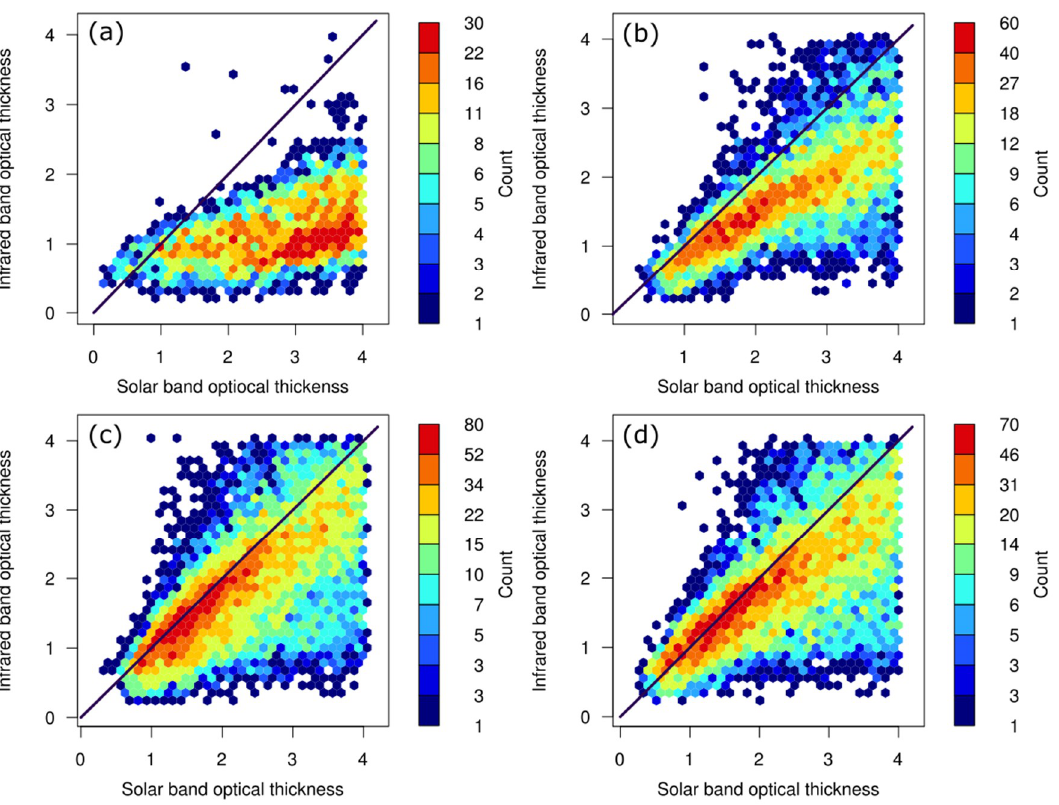
Figure 17. Comparison of retrieved optical thickness values from the shortwave technique (shortwave bi-spectral method) and the longwave technique (split-window method): ( a ) ice sphere; ( b ) CERES Edition 4 model; ( c ) MODIS Collection 6 model; and ( d ) two-habit model (CERES Edition 5 model).